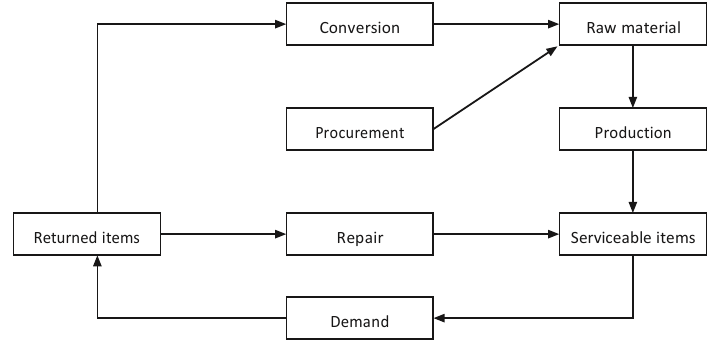
Fig. 1. Flow of items in the proposed inventory